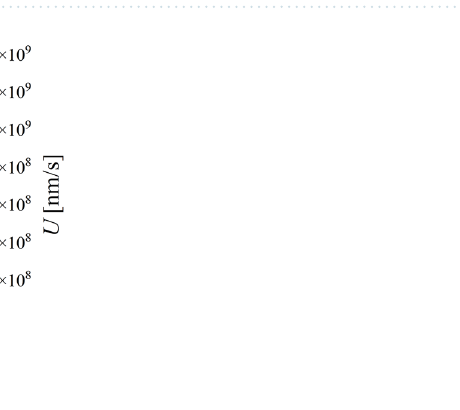
Figure 2. In the panel ( a ), the value of the rotational-invariant order parameter along the direction perpendicular to the solid–liquid interface for the system I is presented. In the panel ( b ), the fluctuation spectrum of the interface height for two RLM systems is shown. The straight lines represent the fit of the linear function with a constant slope equal to − 2.